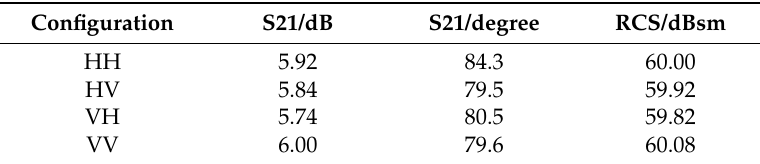
Table 3. RCS consistency measurement of PARC.